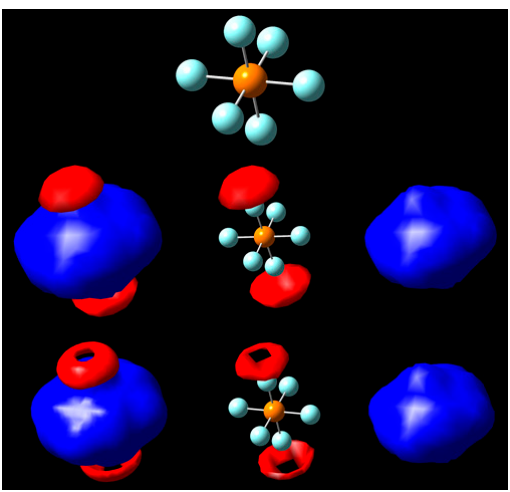
Figure 5. Isopotential surfaces of PF 6 , separated between negative (red) and positive (blue) regions. Isopotential pairs are ±0.30 (second row) and ±0.325 V (bottom). A molecule is given for position reference.